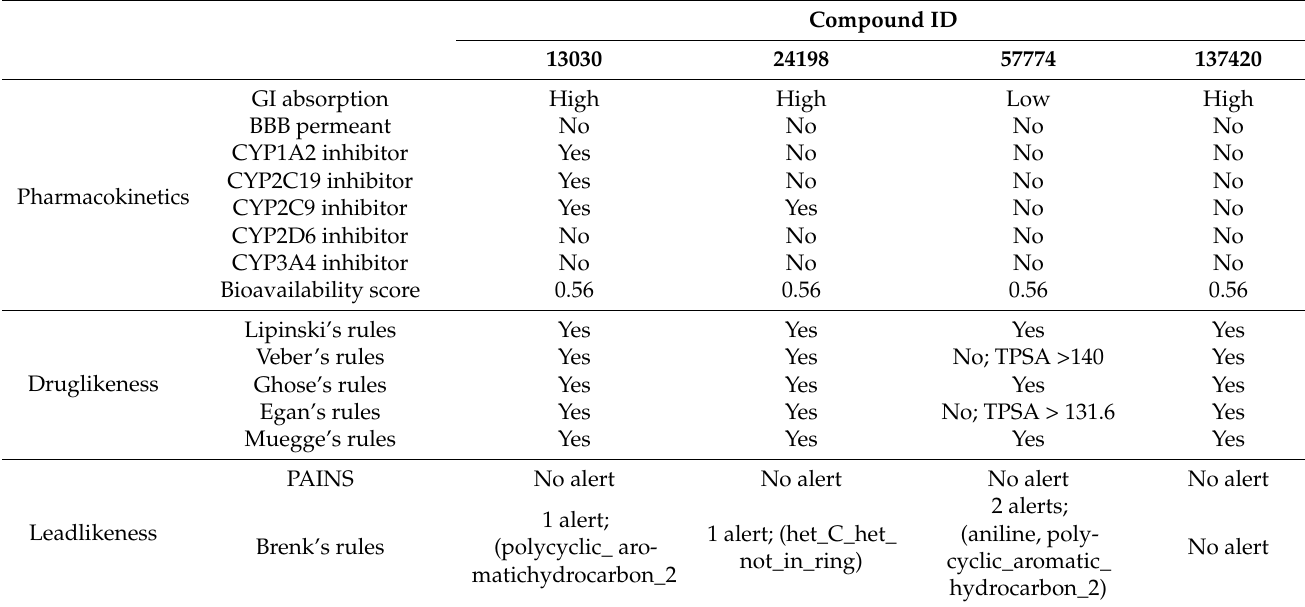
Table 4. Shows the various pharmacokinetic, druglike, and leadlike properties of our best compounds, as predicted by SWISSADME